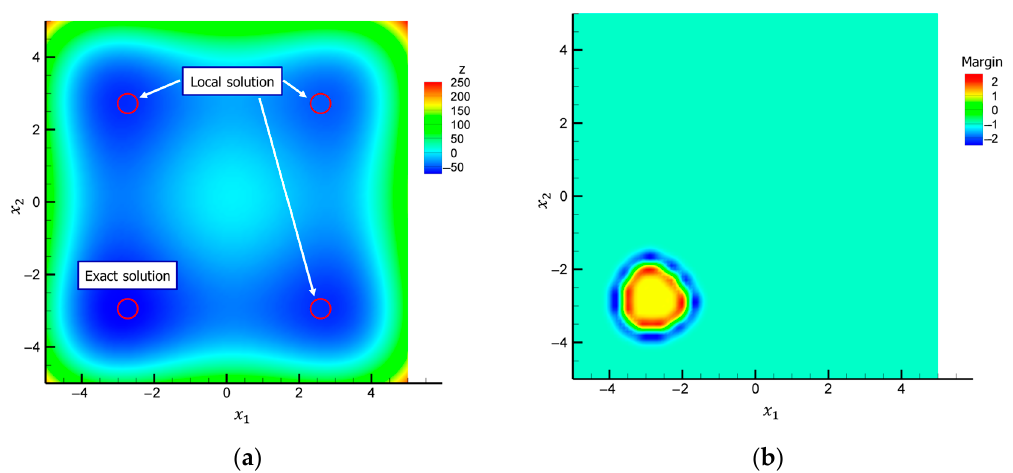
Figure 5. Styblinski–Tang function ( a ) Z contour ( b ) Margin contour